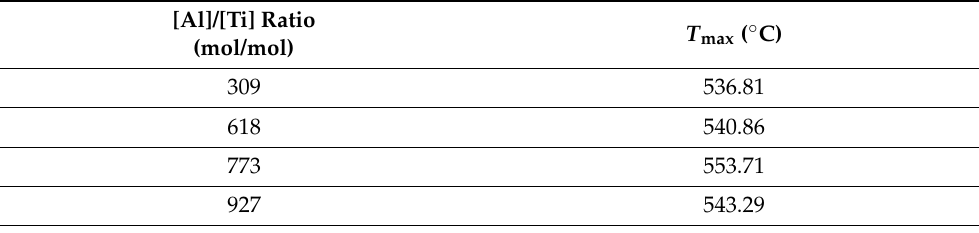
Table 2. Temperature for the maximum rate of decomposition obtained from the TGA thermograms of polyethylene with various [Al]/[Ti] molar ratios.